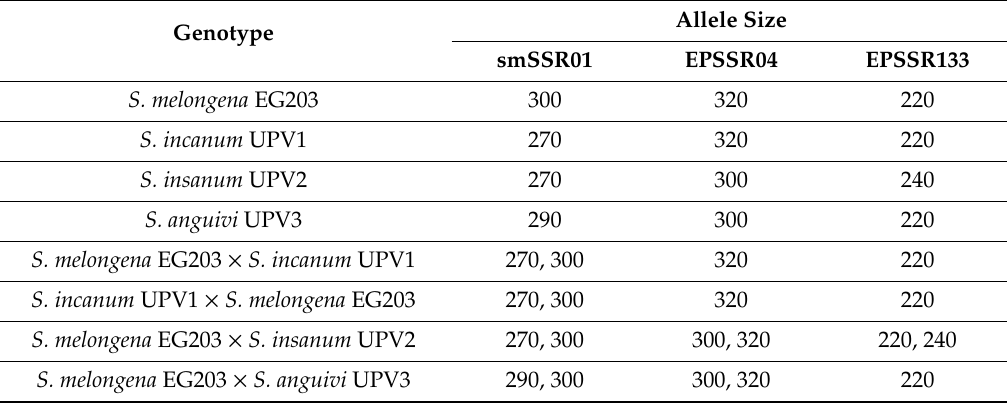
Table 3. Polymorphic bands of Simple Sequence Repeat (SSR) markers in parents and their interspecific hybrids for hybridity